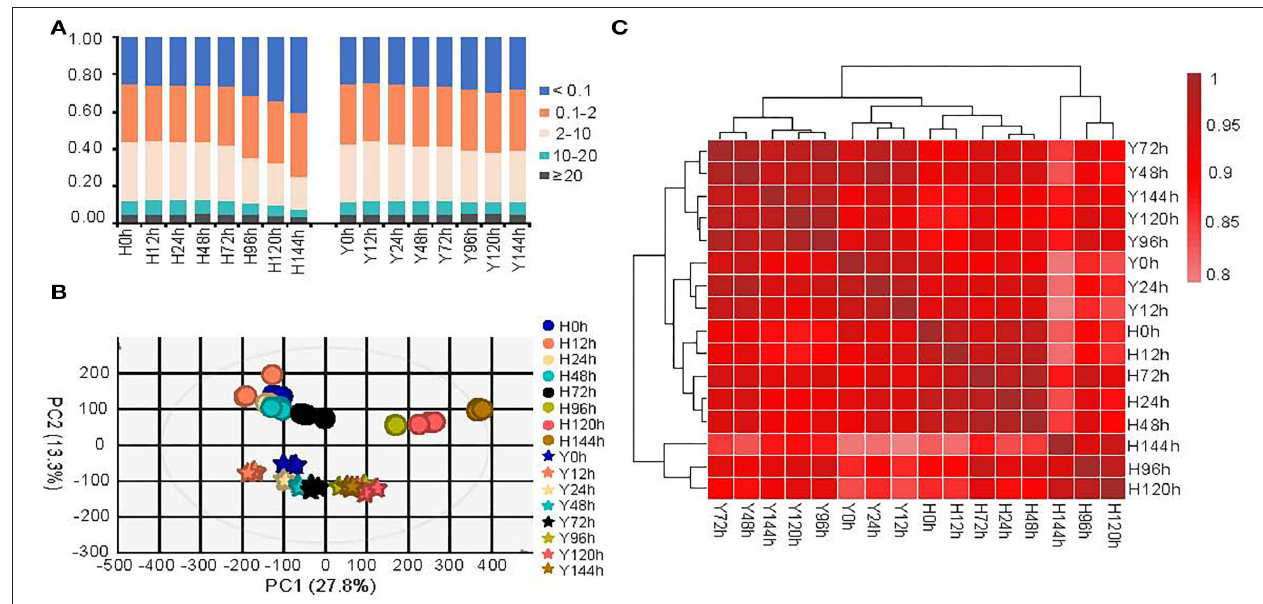
FIGURE 2 | Global views of gene expressions for the resistant strawberry cultivar Y and susceptible cultivar H at all eight time points. (A) Percentage of genes expressed at different expression levels in the two cultivars (based on FPKM). The PCA (B) and the hierarchical clustering (C) based on Spearman’s correlation coefficient of average FPKM values. The circle and asterisk represent the cultivar H and Y in PCA,